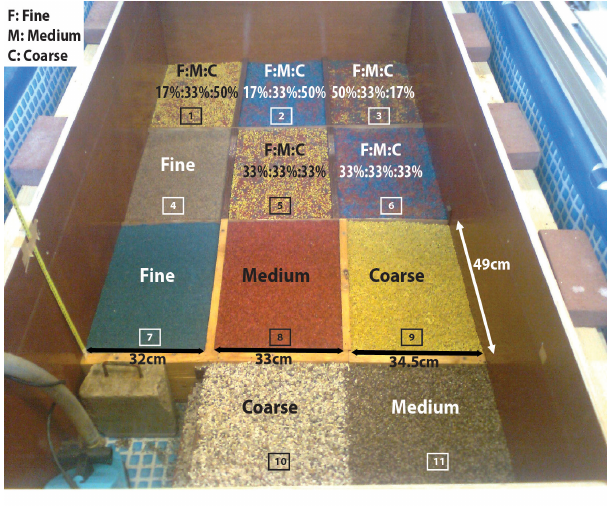
Figure 9. Settings of the image analysis experiment. Grain-size distribution within the compartments, compartment geometry and